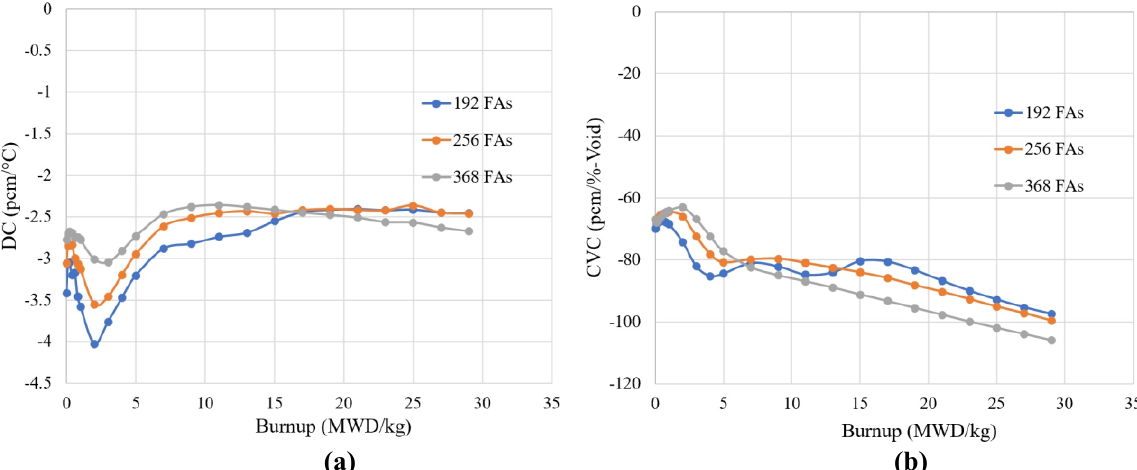
Figure 6. Depletion Behaviour of Reactivity Feedbacks for the Studied Geometries: (a) Doppler Coefficient; (b) Coolant Void Coefficient.